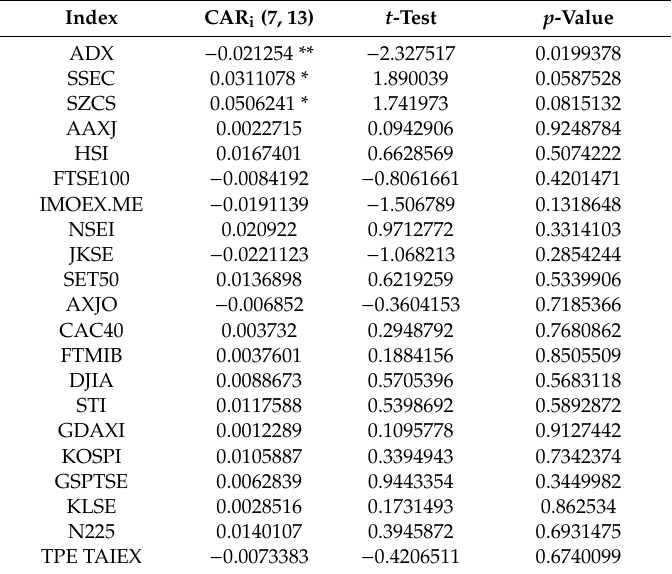
Table 6. Cumulative abnormal return in the event window (7, 13).